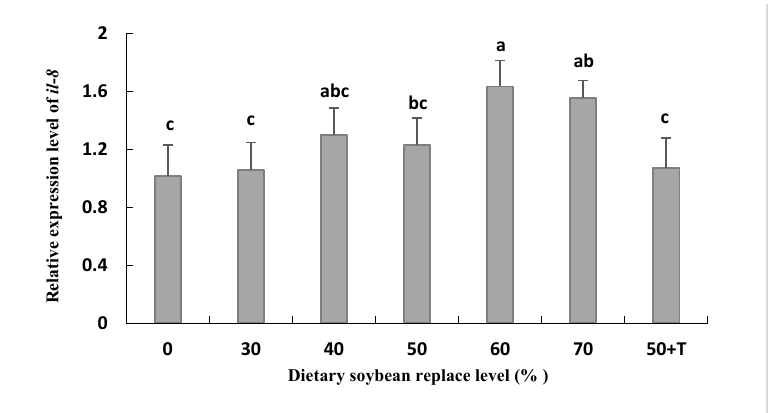
Figure 4. Relative expression of the mRNA for cytokine interleukin-8 ( il-8 ) in the liver of Oplegnathus punctatus fed the seven diets. Means in the same row with different superscripts are significantly different ( p < 0.05).